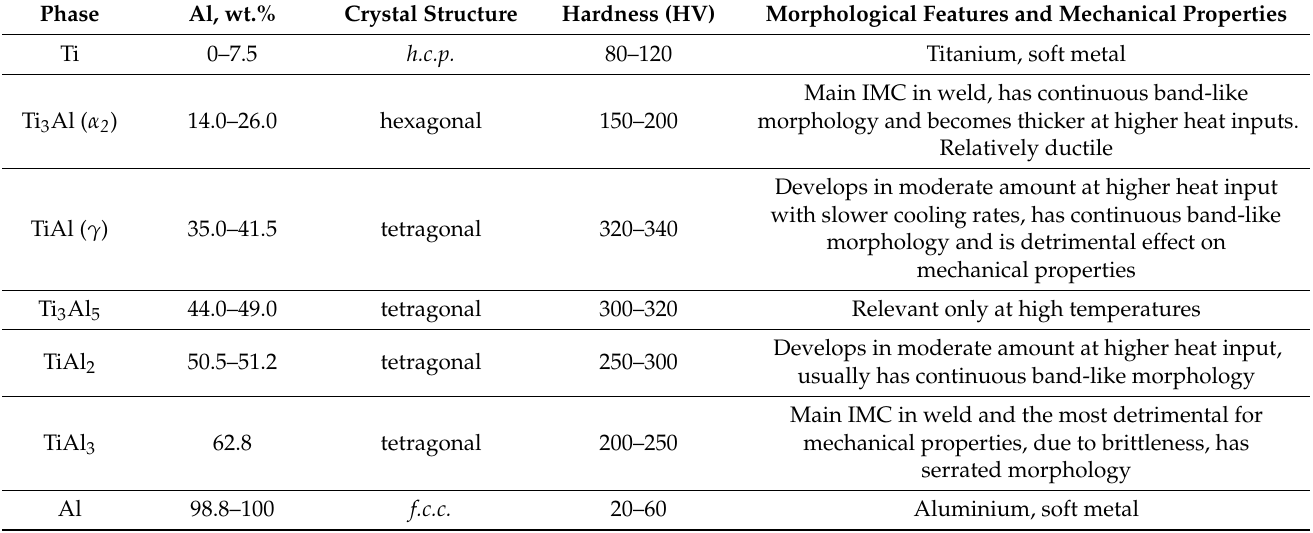
Table 7. Characteristics of different Ti x Al y phases forming at room temperature [88,122,181]. Composition of Al (in wt.%) varies depending on